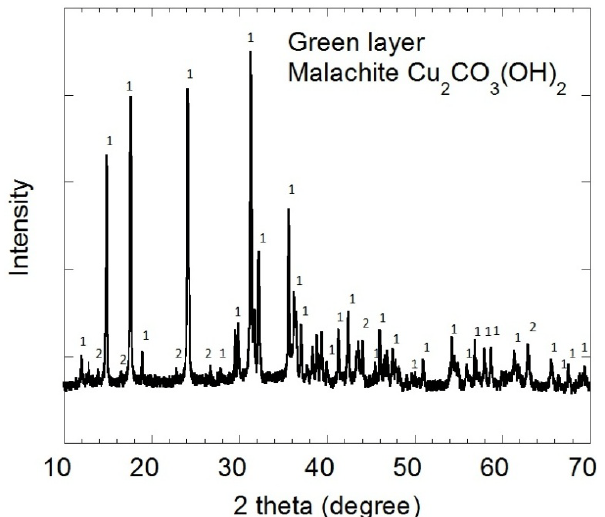
Figure 3. The XRD spectra for the green layer correspond primarily to malachite (peaks labeled